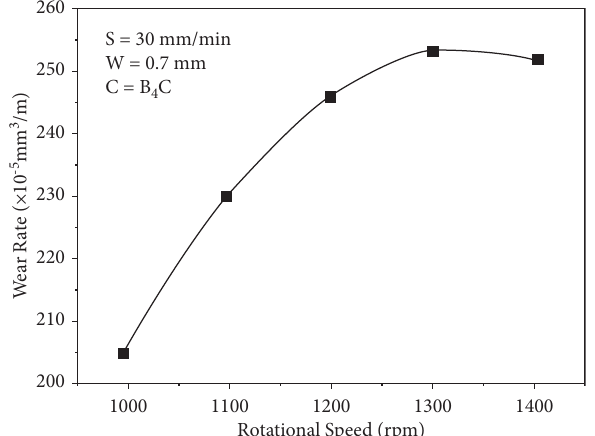
Figure 17: Variations in the wear rate of CuNi/B 4 C surface composite as a function of tool rotational